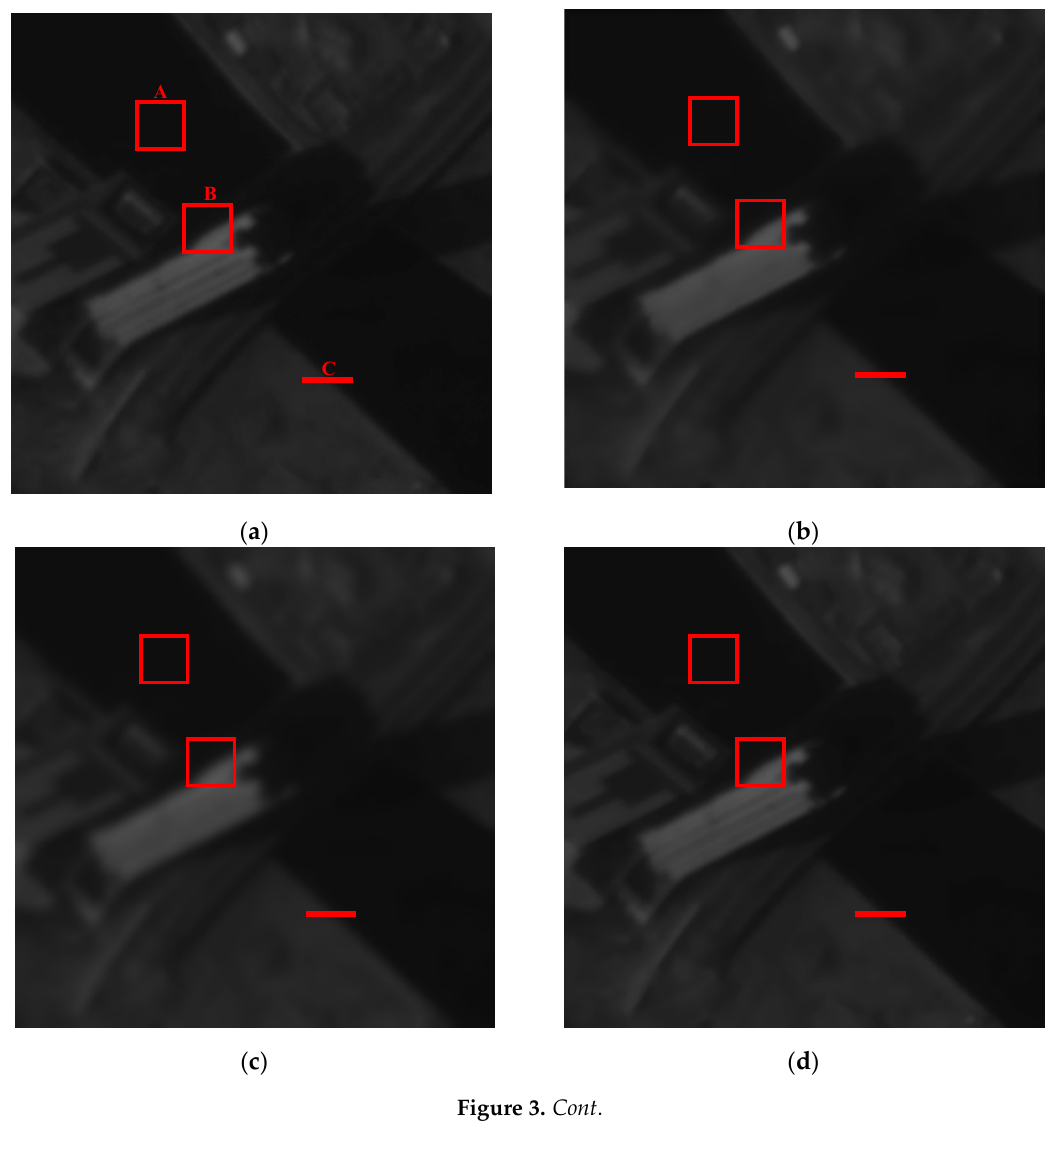
Figure 3h. The different gray level distributions of edge C are depicted in Figure 3i,j.